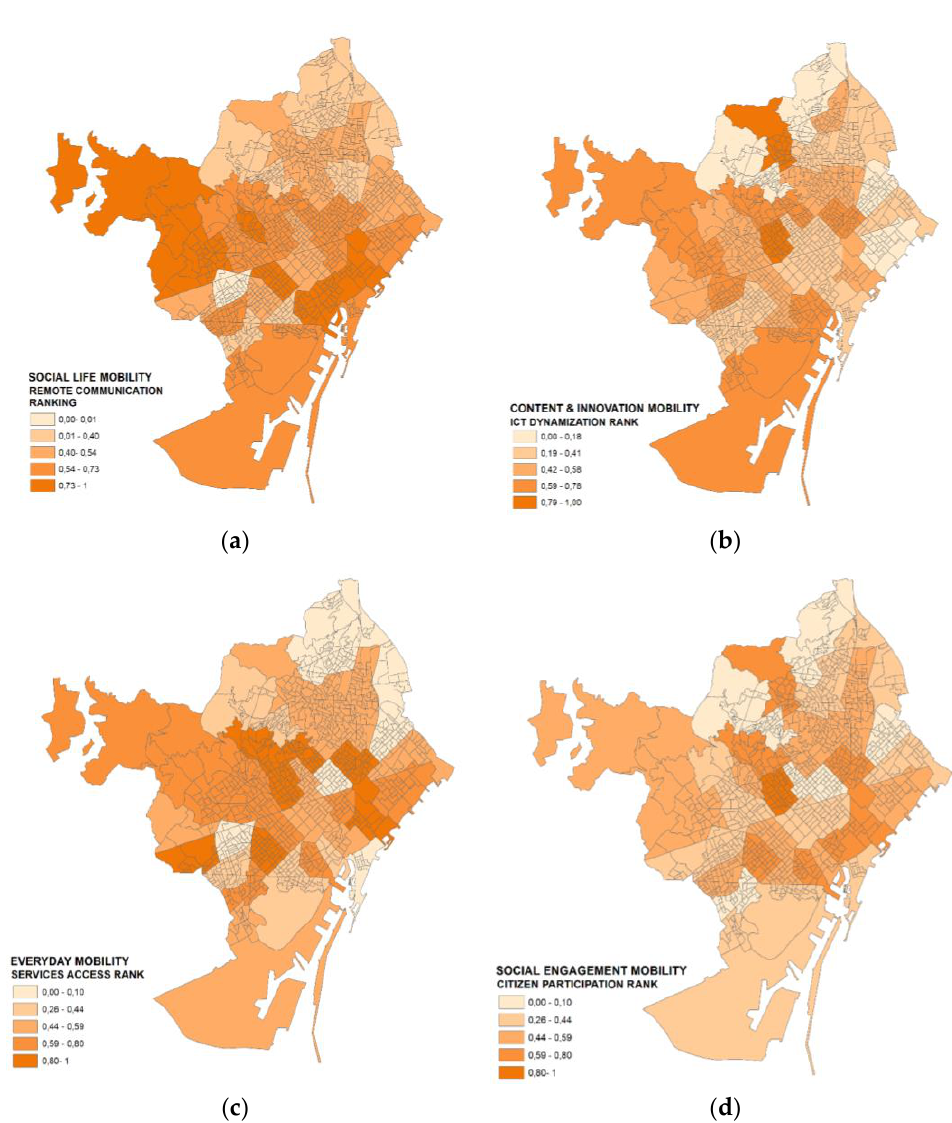
Figure 3. Digital Mobility by typology. ( a ) Synthetic index: Social life mobility; ( b ) Synthetic index: Content and innovation mobility; ( c ) Synthetic index: Every day mobility; ( d ) Synthetic index: Social engagement mobility, Barcelona City.